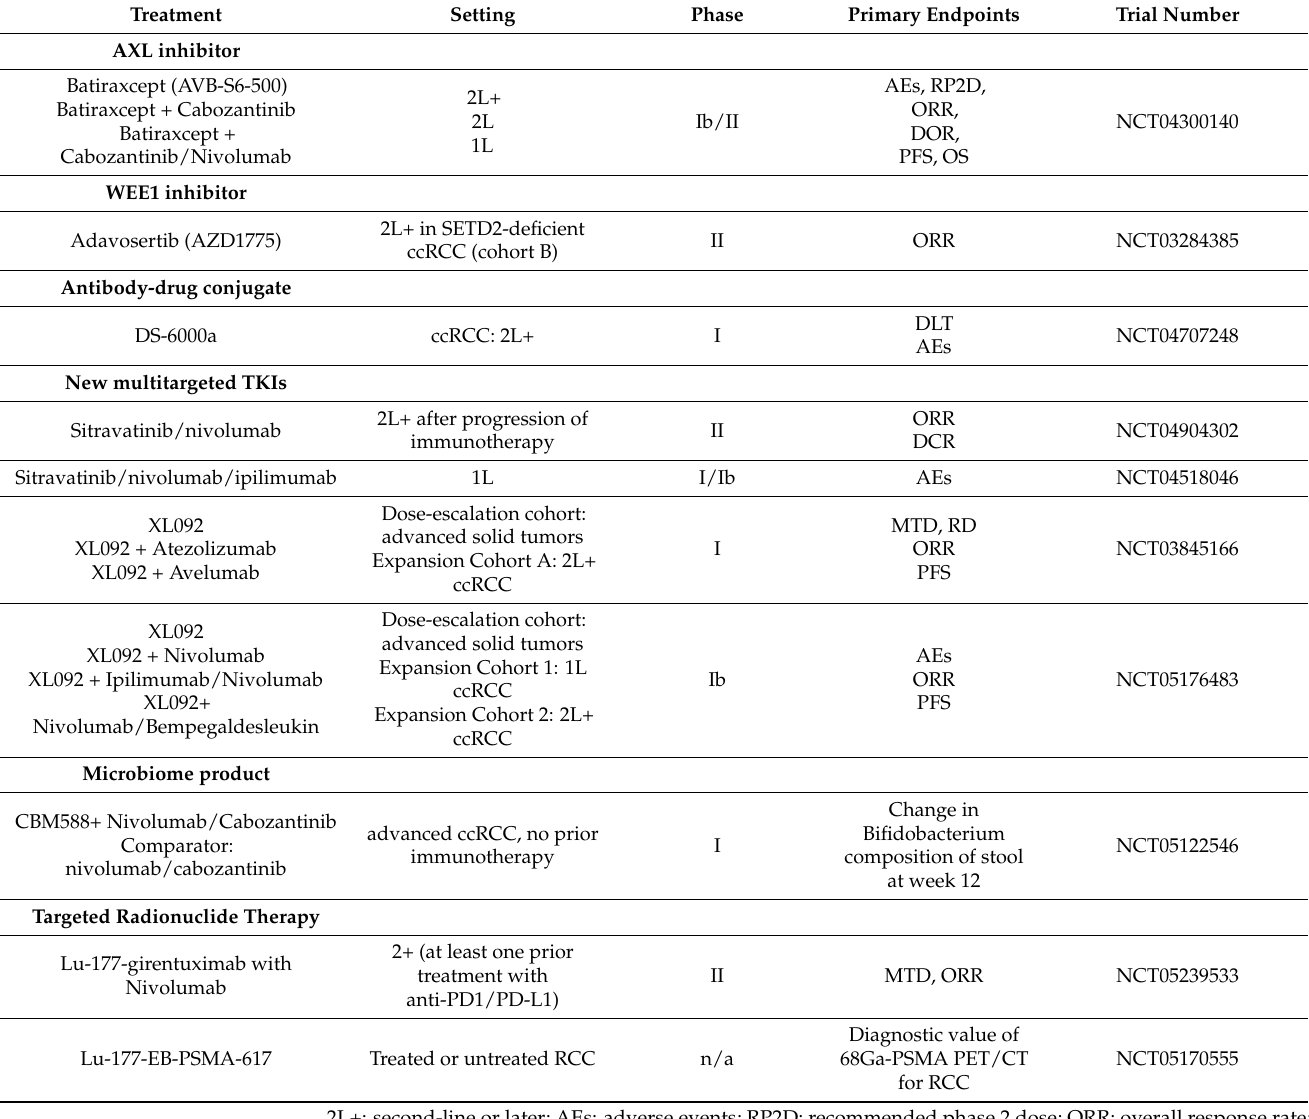
Table 3. Ongoing clinical trials targeting novel